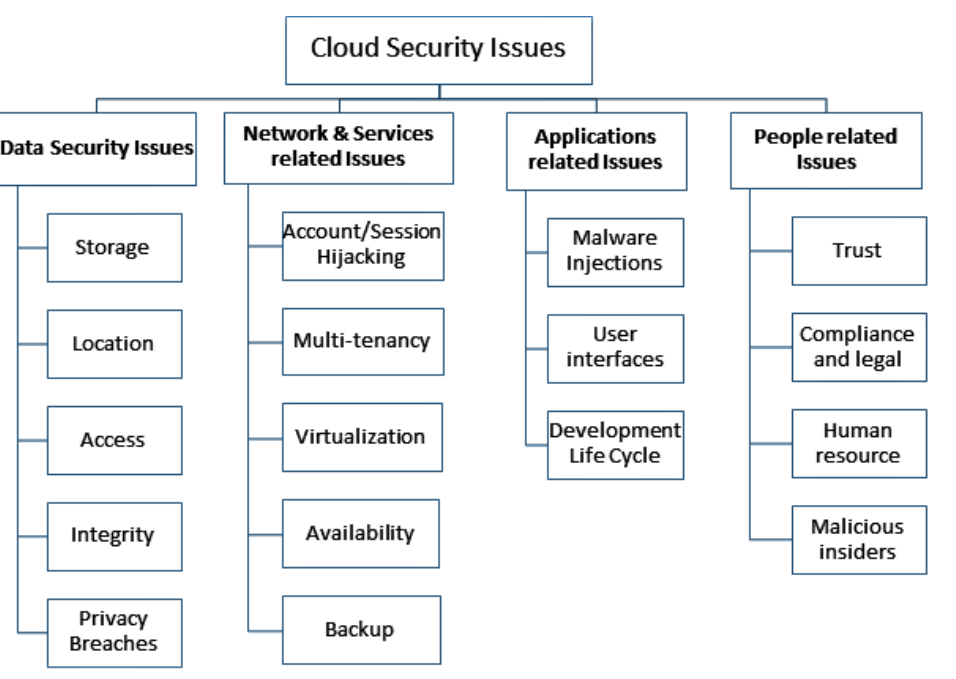
Figure 16. Summary of security issues in each